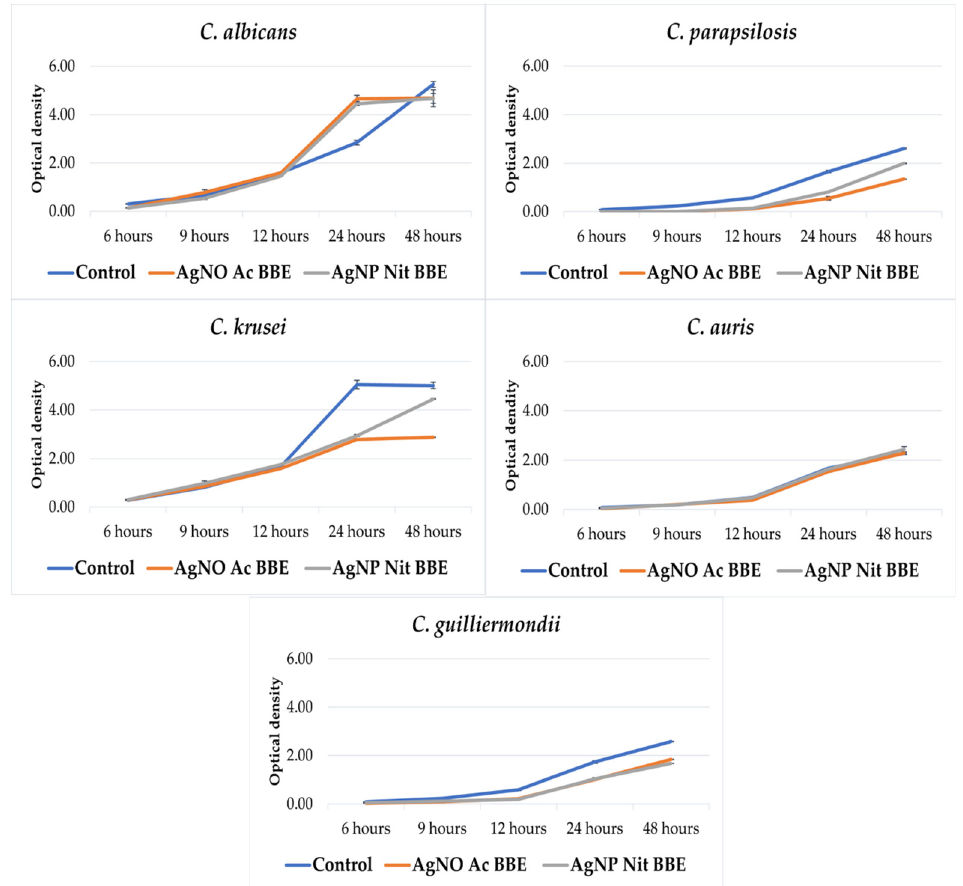
Figure 1. The effect of the AgNP BBEs on the growth rate of Candida spp.